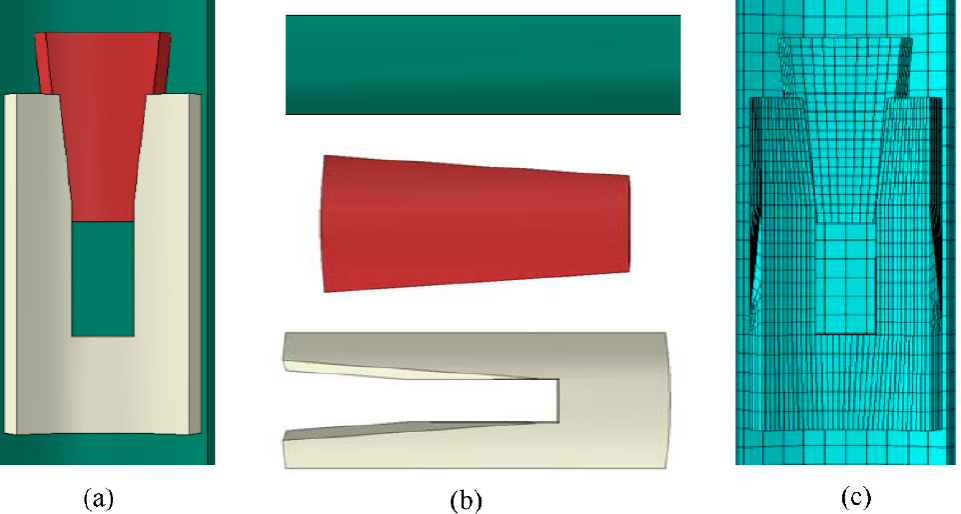
Figure 6. Finite element model of hanging mechanism. ( a )Assembly; ( b ) part; ( c ) mesh.